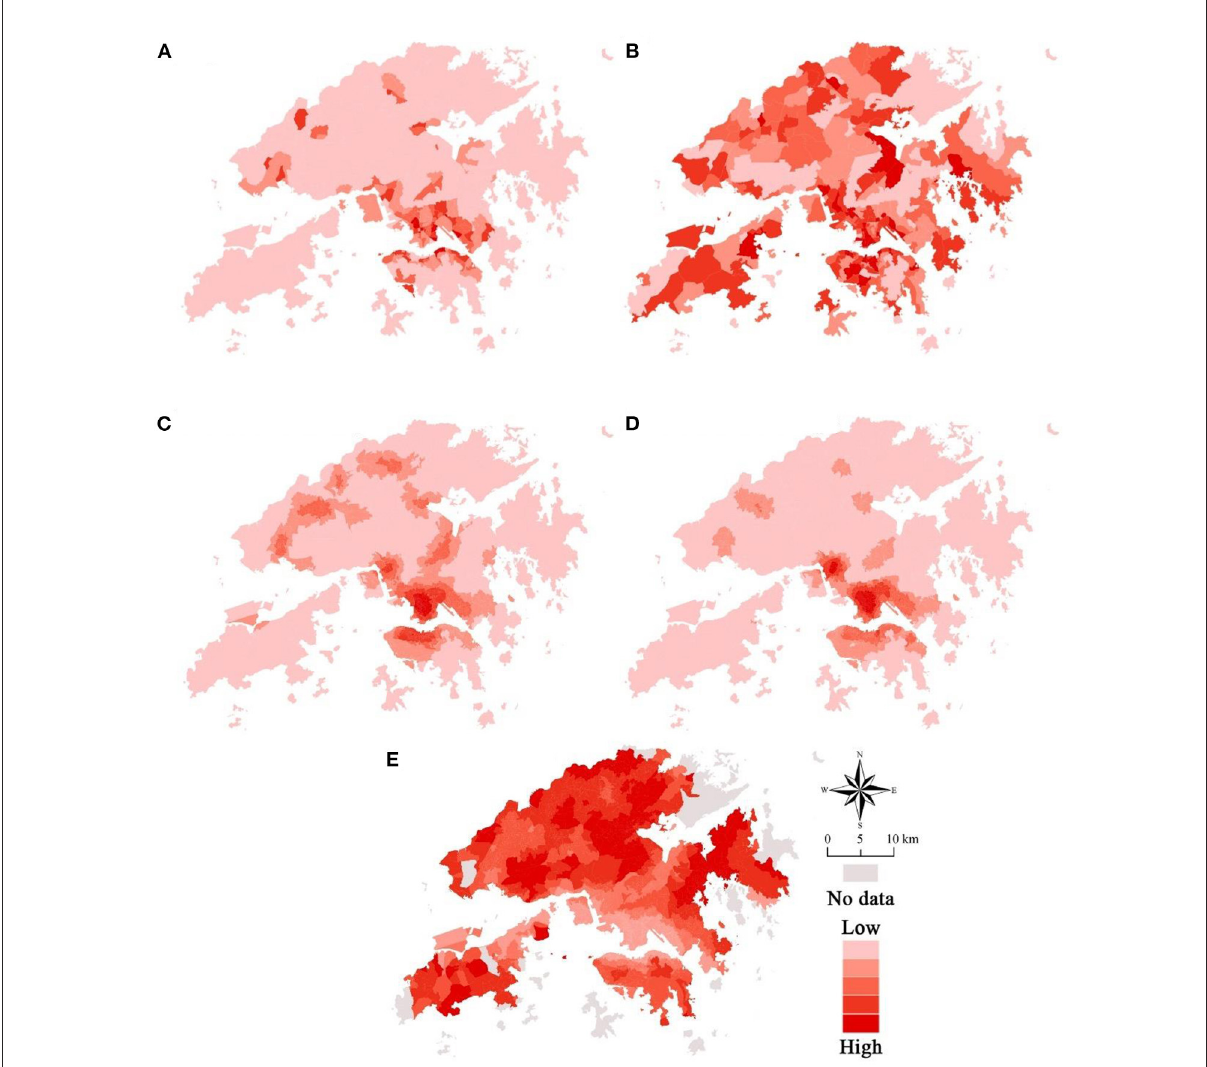
FIGURE4 The spatial distribution of the five built environment attributes. (A) Population density. (B) Land-use mix. (C) Intersection density. (D) Access to bus stops. (E) Street